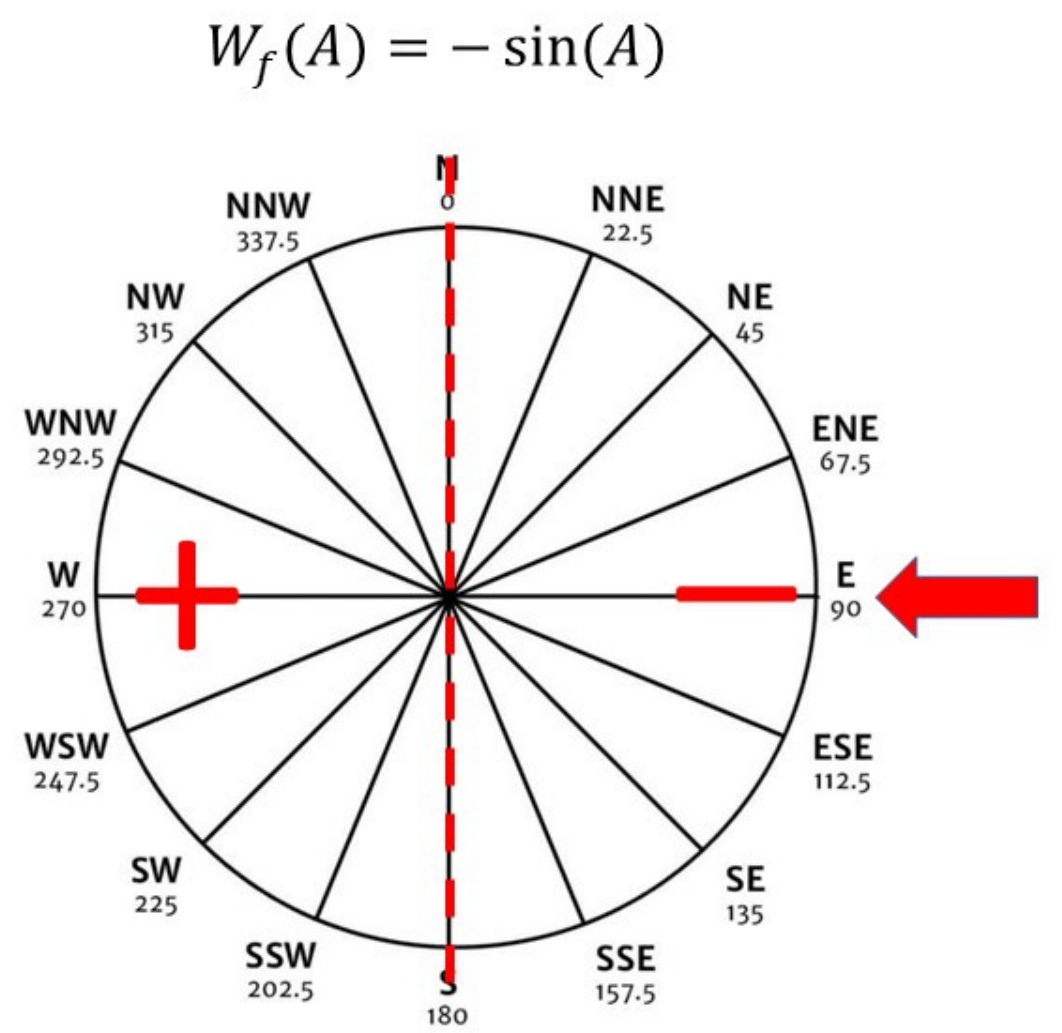
Figure A1. Wind factor illustration for an easterly wind were derived similarly to the wind equations found in Dvornikov et al 2015